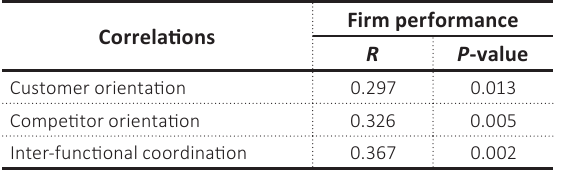
Table 10. Analysis of correlation between market orientation and corporate performance